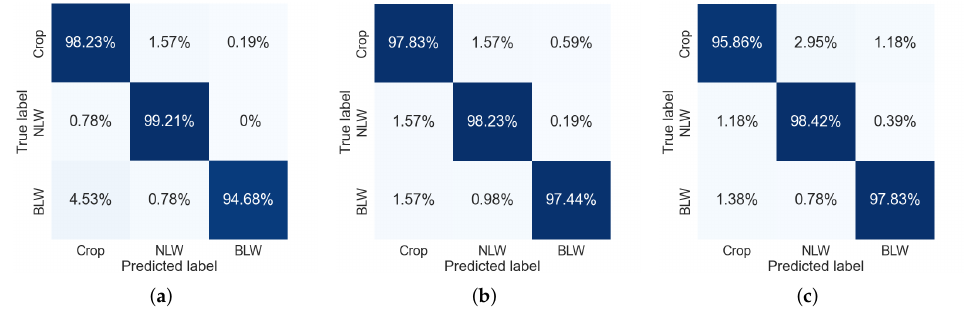
Figure 14. Confusion matrices of the three CNN models. ( a ) VGG16. ( b ) VGG19. ( c )